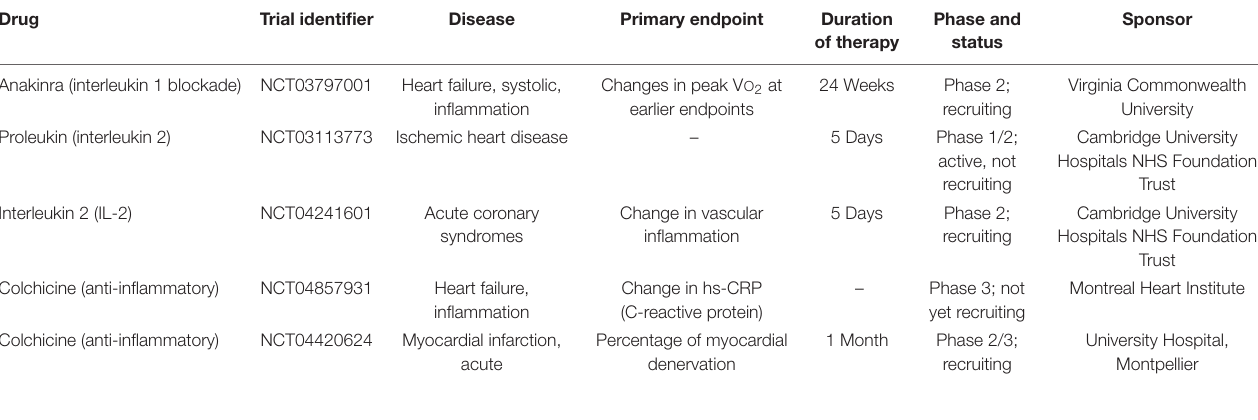
TABLE 3 | Ongoing clinical trials targeting